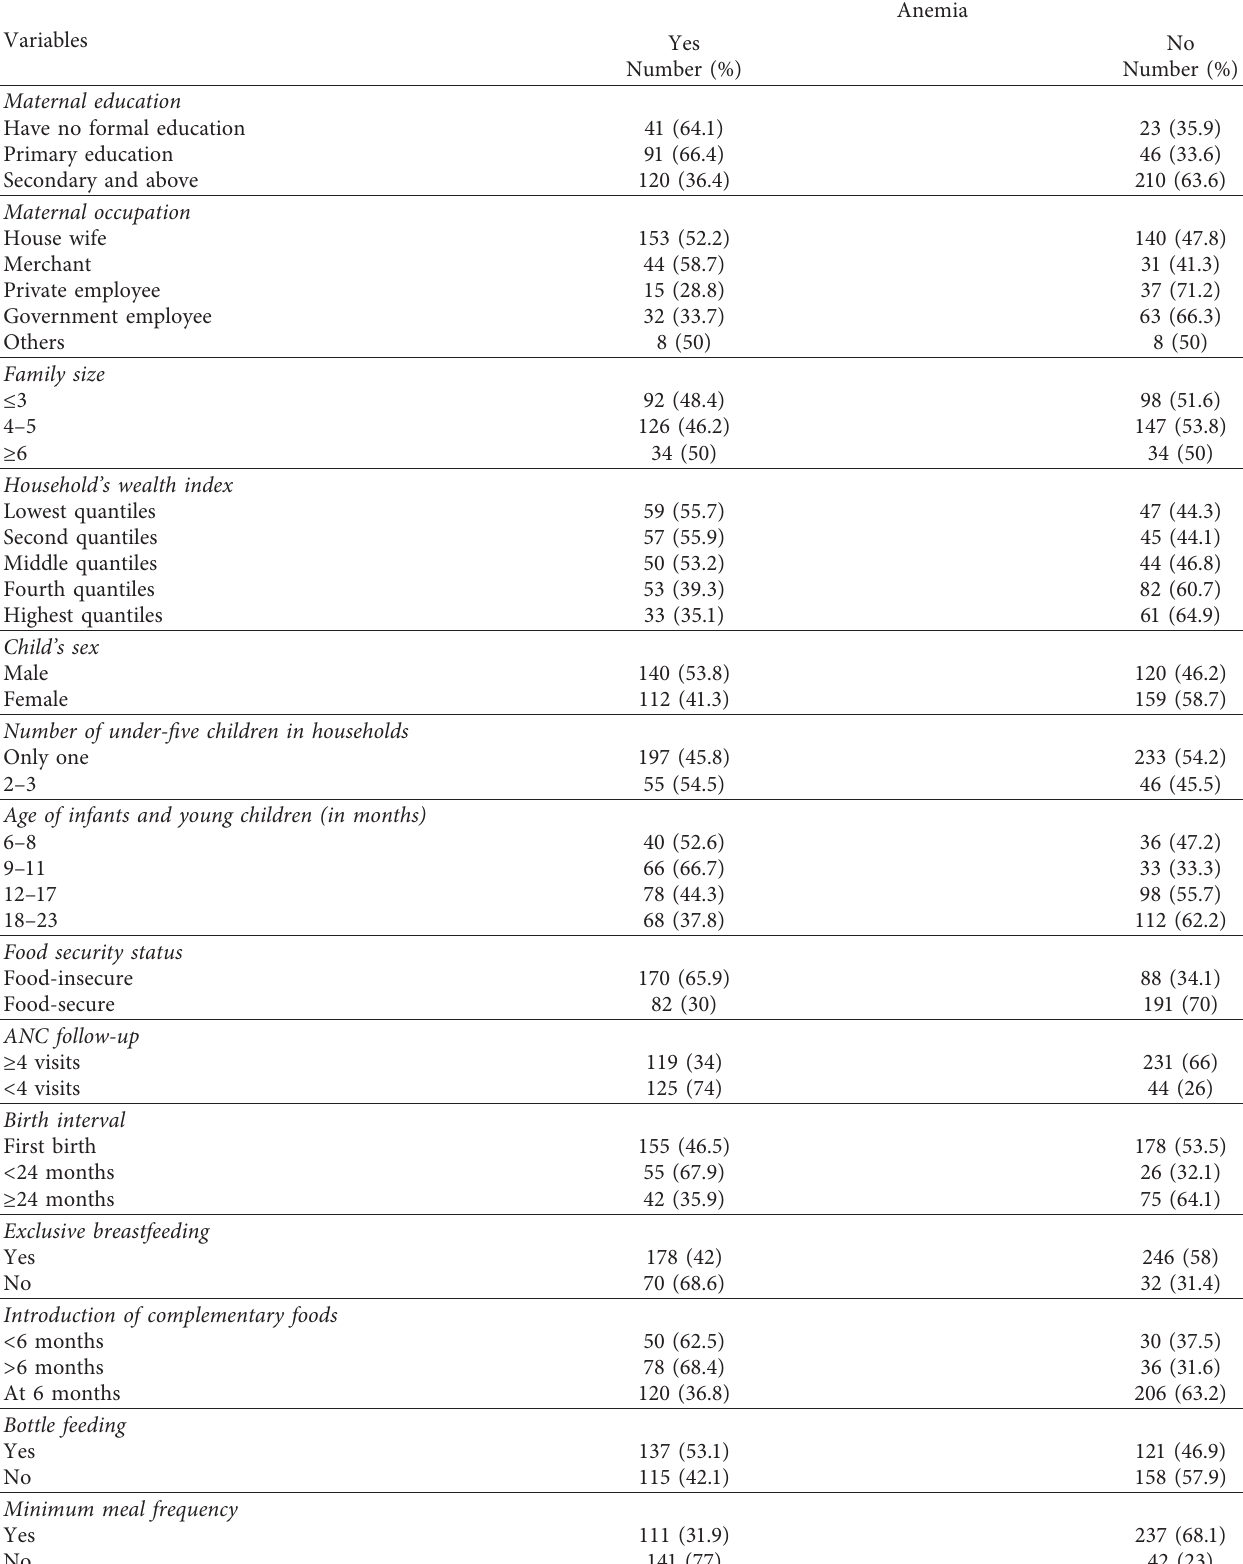
Table 4: Prevalence of anemia among infant and young children aged 6–23 months by selected maternal and child characteristics in Debre Berhan Town, Ethiopia, 2018 ( n �